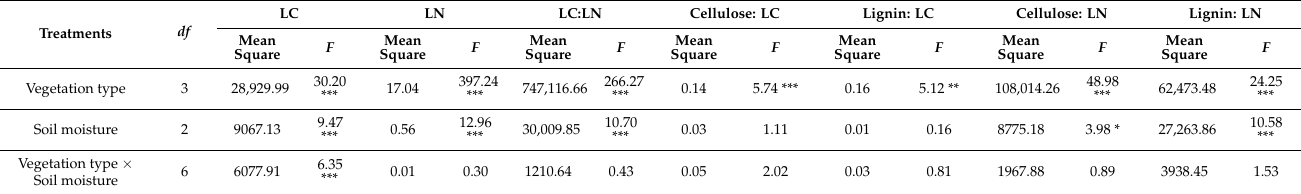
Table 2. Multivariate analysis of variance of vegetation type and soil moisture and litter